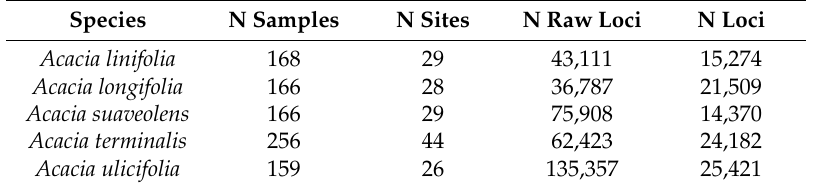
Table 1. Summary of sampling strategy (site details in Supplementary Table S2) and genomic data used for each Acacia species. N samples (number of samples analysed, samples with greater than 50% loci missing were removed); N sites (sampled); N raw loci (number of loci generated by DArTseq); N loci (number of loci remaining for the analyses after standard filtering process involving the removal of loci with 20% missingness and with minimum reproducibility of